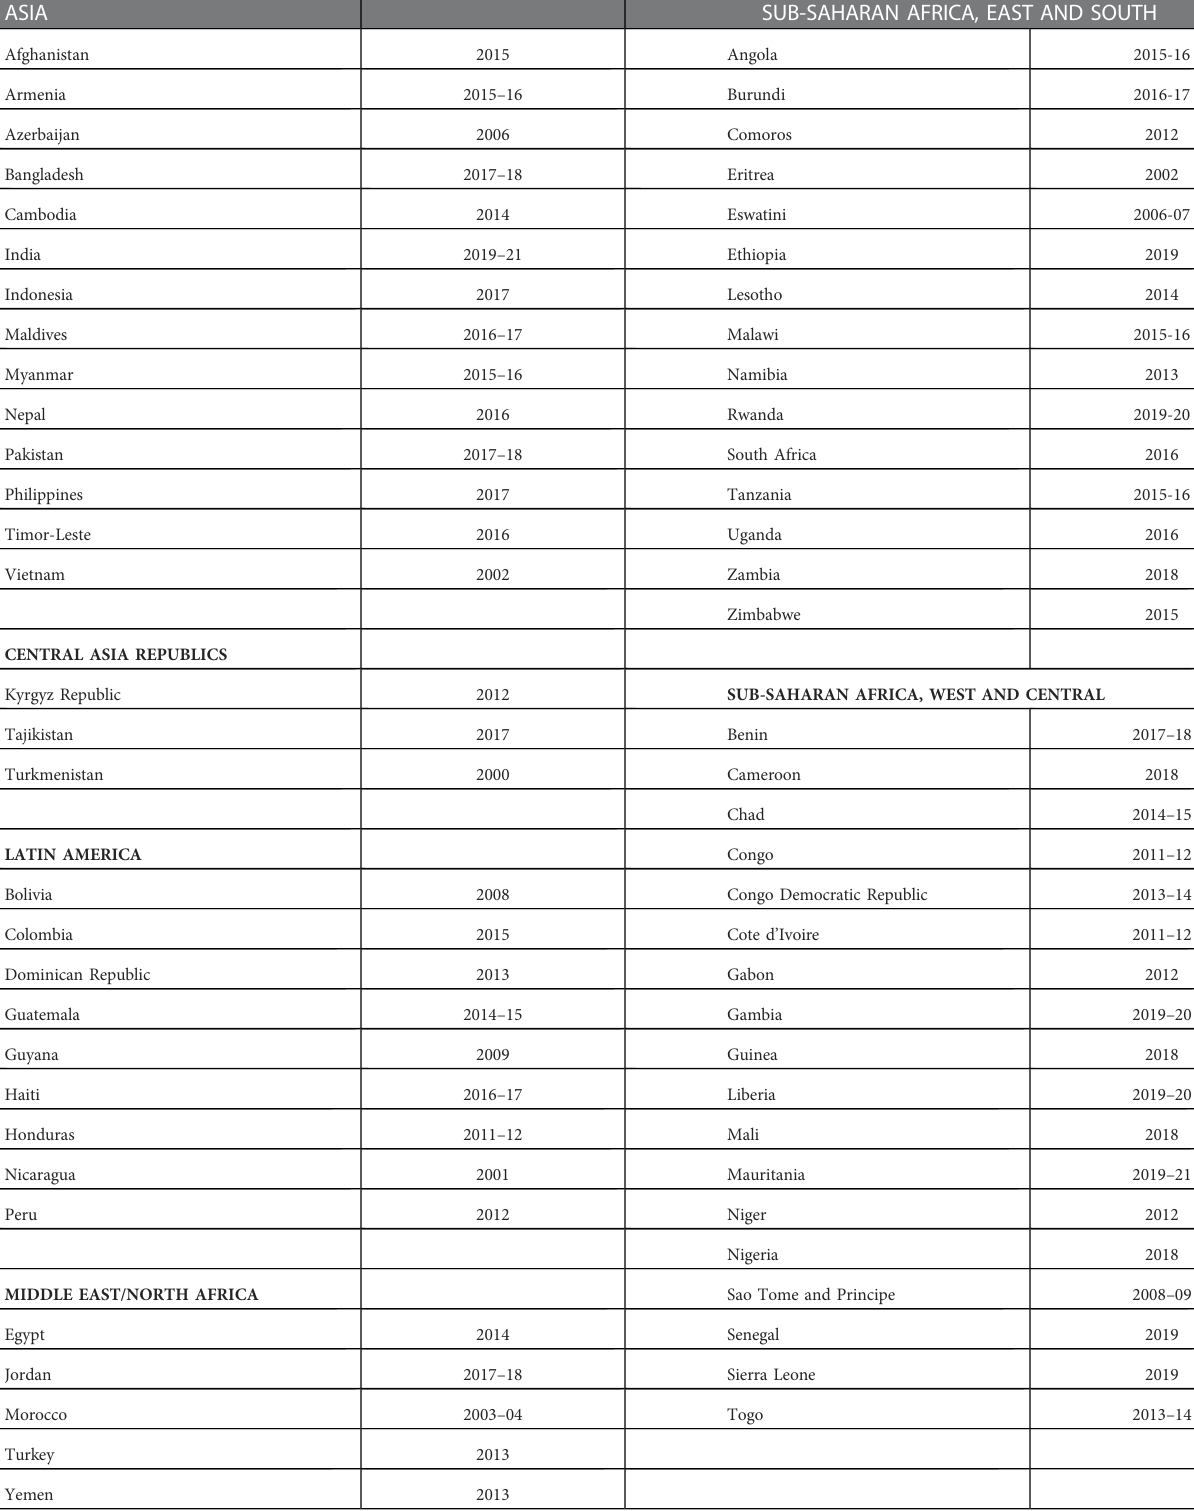
TABLE 1 64 DHS surveys by